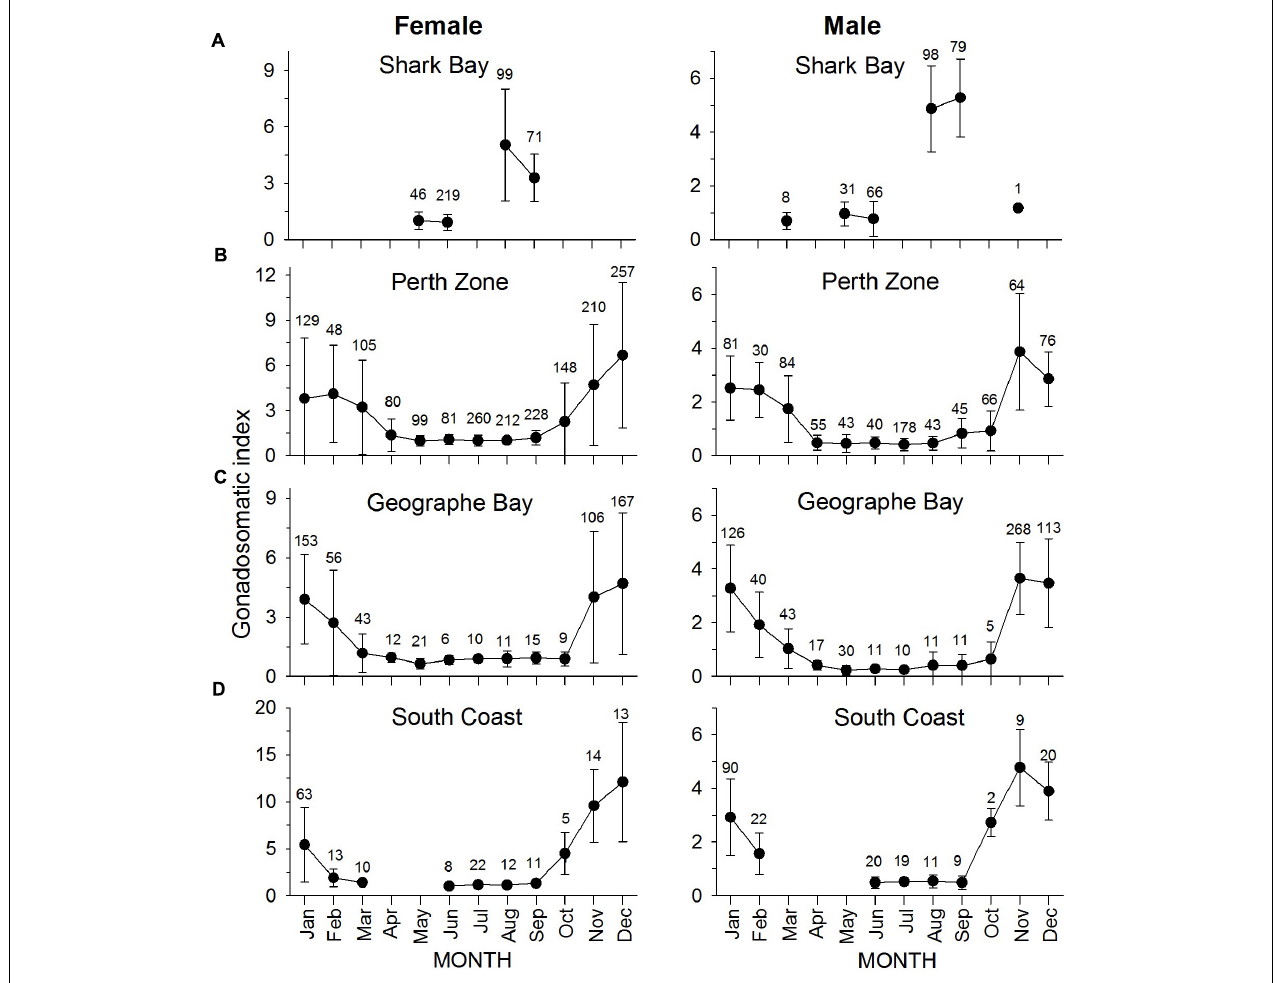
FIGURE 7 | Monthly mean ( ± SD) gonadosomatic index for female (left column) and male (right column) S. schomburgkii in (A) Shark Bay, (B) Perth Zone, (C) Geographe Bay, and (D) South Coast. Each data point is labeled with number of fish sampled.